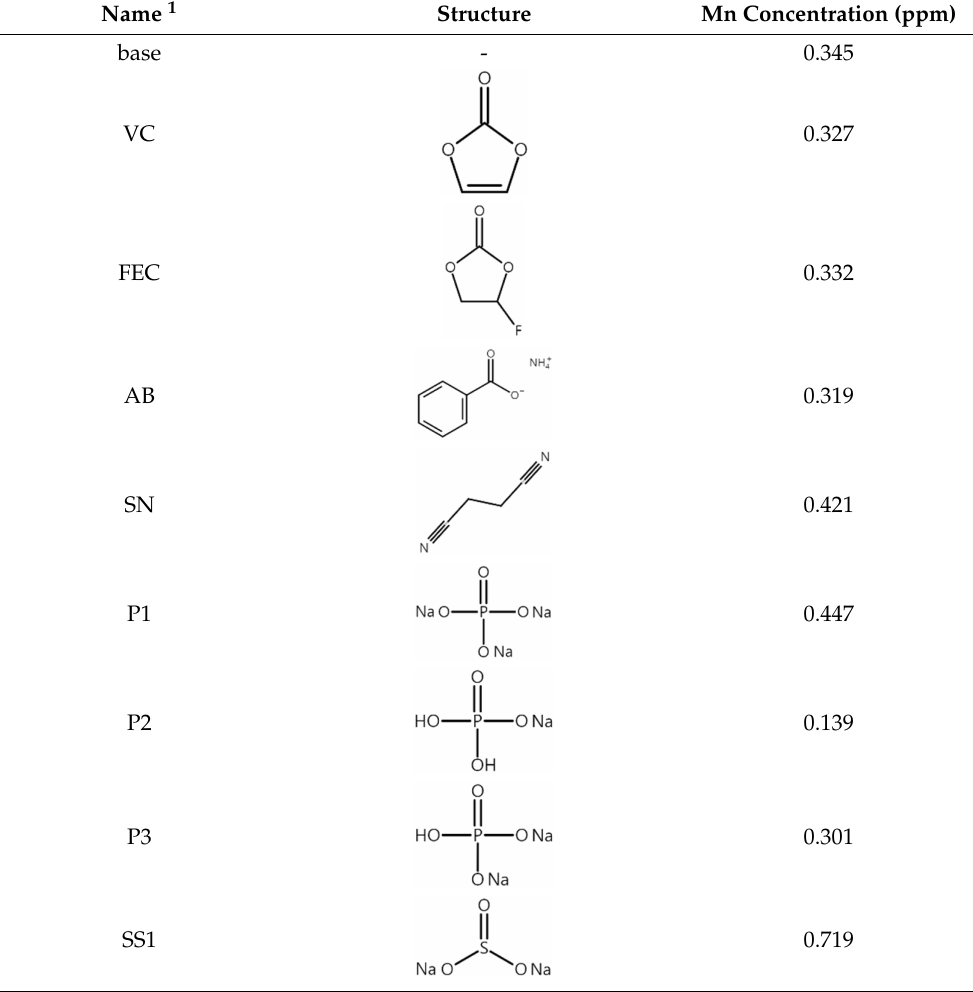
Table 1. Comparison of dissolved Mn concentration with various electrolyte additives after the storage